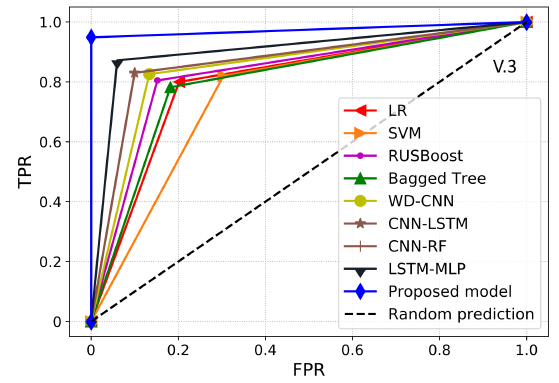
Figure 7. Proposed model’s PR-AUC-based analysis with IQMOT.